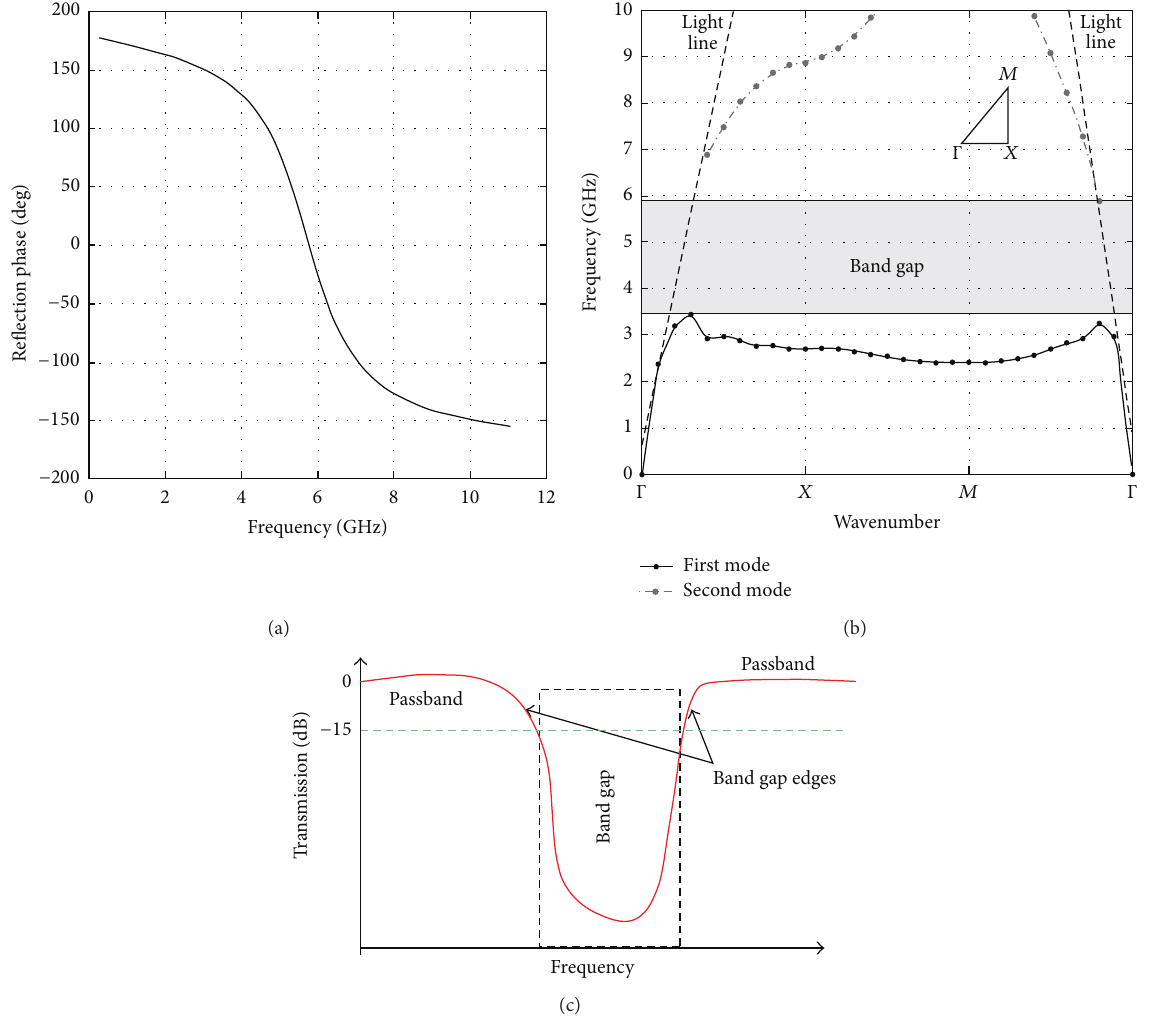
Figure 3: Identification of bandgap of a EBG surface (a) reflection phase (b), dispersion diagram, and (c) transmission loss plot.